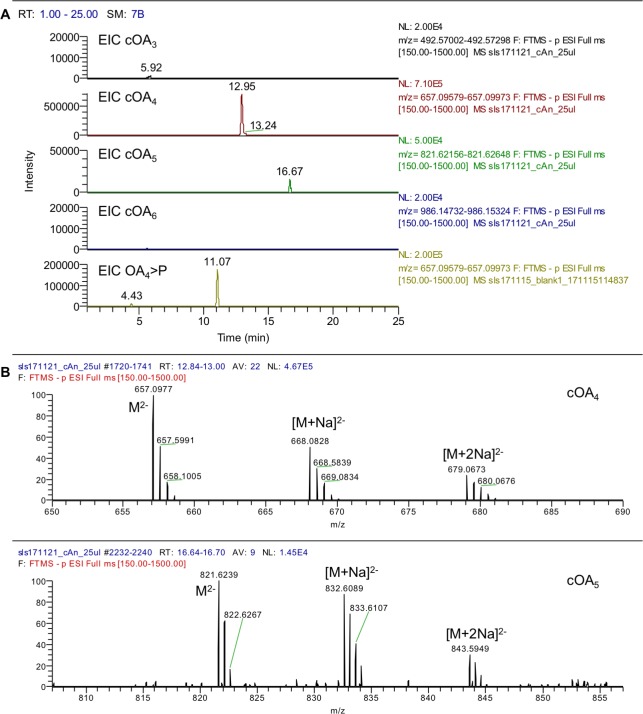
LC-MS analysis of cOA production by S. solfataricus Csm.(A) Extracted ion chromatograms (EIC) are provided as indicated in the panels. The data confirm that cOA4 is the major product; cOA5 is present at significantly lower concentration. No other oligoadenylate species were present above the MS detection limit. The EIC for linear MazF-derived OA4 >P demonstrates the difference in chromatographic retention for the isomeric species. (B) High-resolution mass spectra for 12.9 min (cOA4) and 16.7 min (cOA5) retention time showing the doubly charged molecular ion peak alongside mono- and disodium adducts. Expected for cOA4 C40H48N20O24P4 1316.2101, found 1316.2100 (-0.1 ppm); expected for cOA5 C50H60N25O30P5 1645.2626, found 1645.2618 (-0.5 ppm).